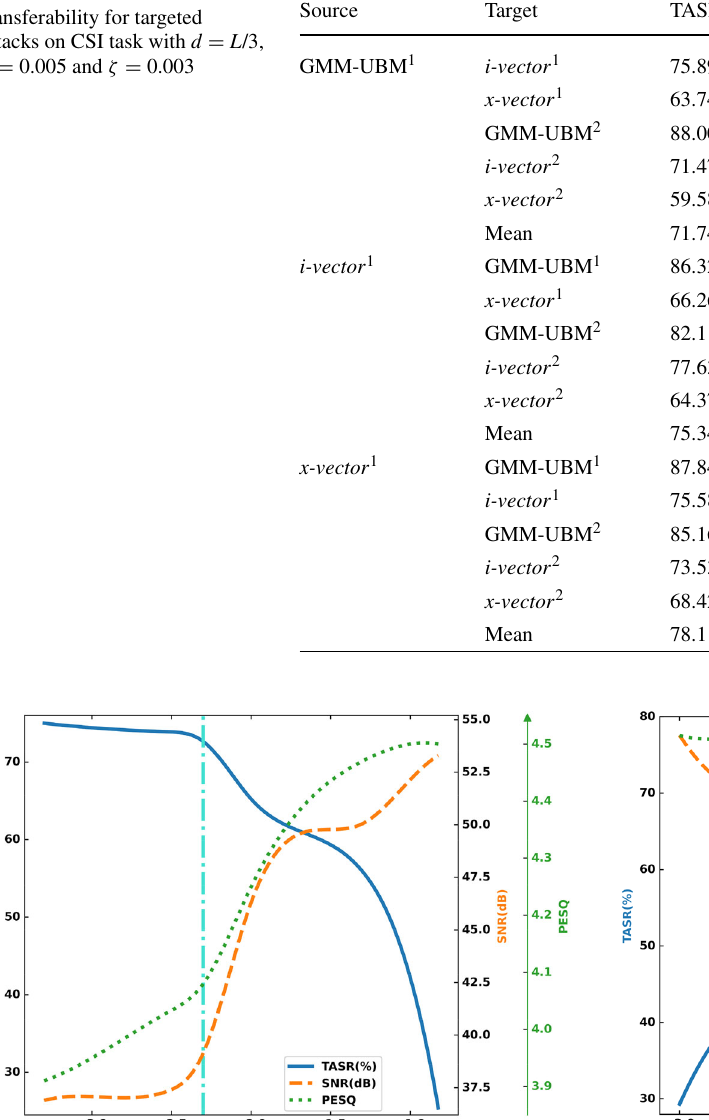
Table 8 Evaluation of transferability for targeted attacks on CSI task with d (cid:2) L /3, λ (cid:2) 0.005 and ζ (cid:2) 0.003